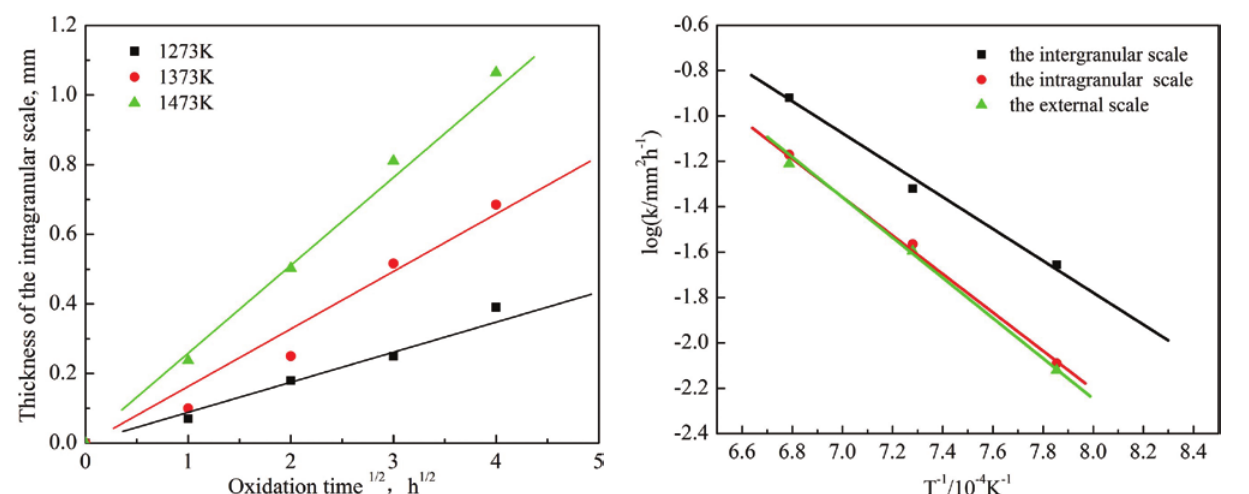
Fig. 9: Relationships between the thickness of the intragranular subscale and the square root of oxidation time